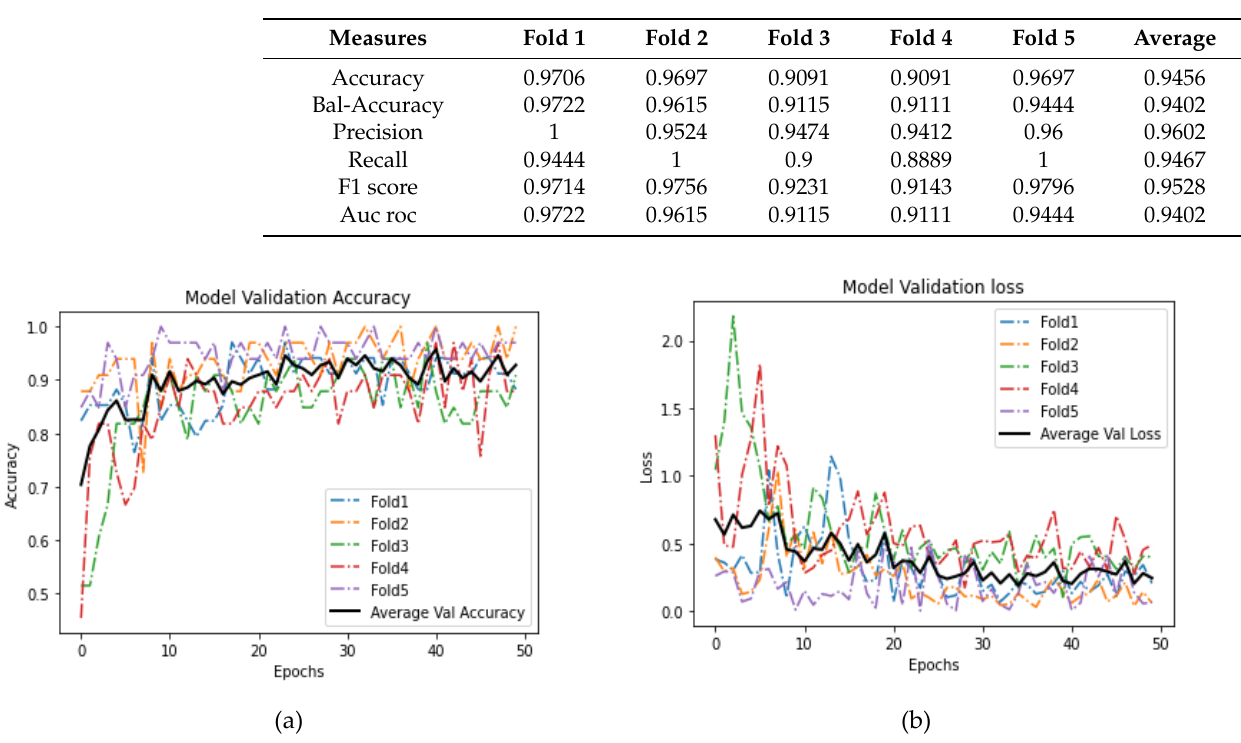
Table 1. K-folds performance results using MobileNet.